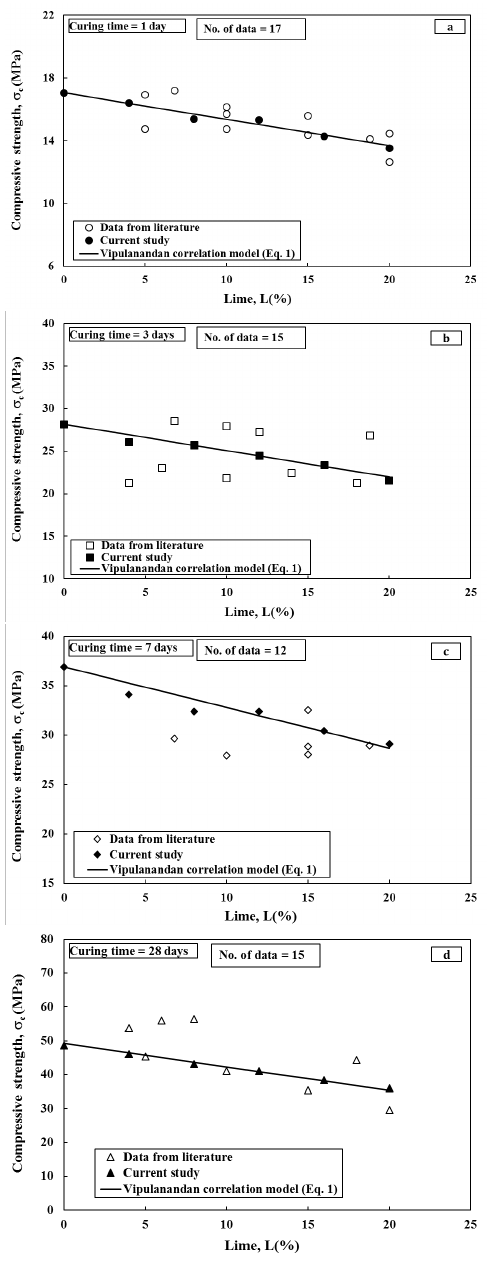
Figure 10: Relationship between Lime content and compressive strength of cement mortar at different curing times (a) 1day (b) 3 days (c) 7 days and, (d) 28 days of curing